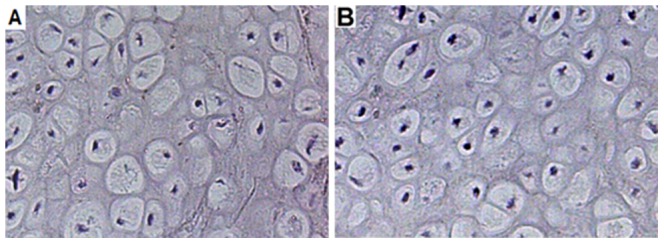
Immunohistochemistry of vascular endothelial growth factor (VEGF) expression within the callus of a control animal (A) and a telmisartan-treated (B) at 2 weeks post-fracture.